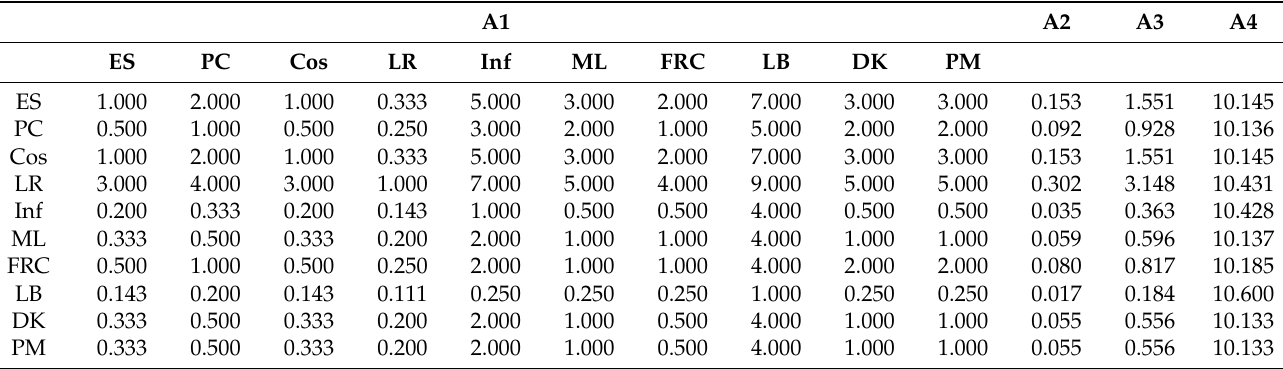
Table 7. Calculation of the Lambda max